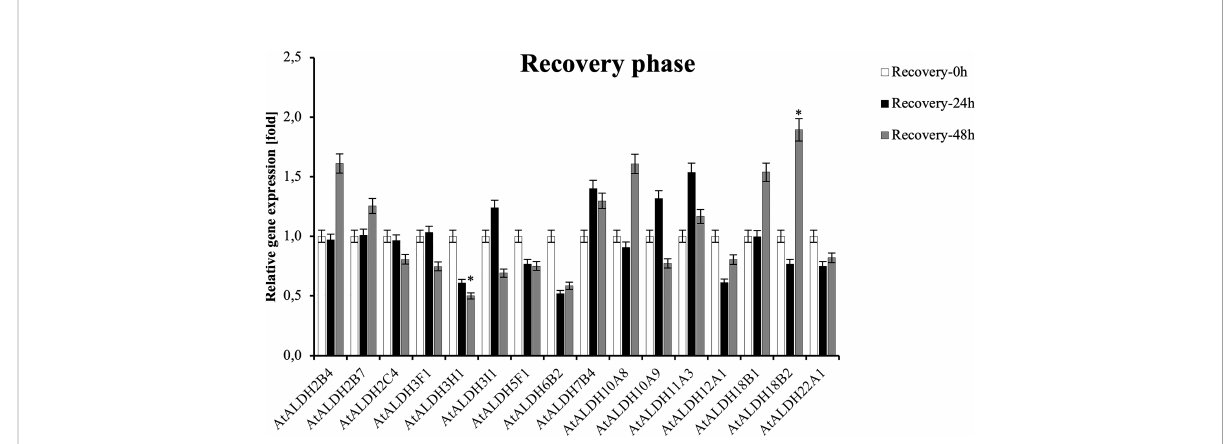
FIGURE 11 Relative gene expression of AtALDHs under recovery phase. Analyses were performed in Arabidopsis leaves of plants recovered from 24 h hypoxia stress at selected time points: 0h (control), 24h, 48h. All values represent means of data ± SD of at least three independent experiments ( n =9). Asterisks (*) indicate values that differ signi fi cantly during recovery phase as compared to the control at a <0.05, respectively. The analysis of variance was conducted and the least signi fi cant differences (LSDs) between means were determined using Tukey ’ s test at the level of signi fi cance a =0.05.